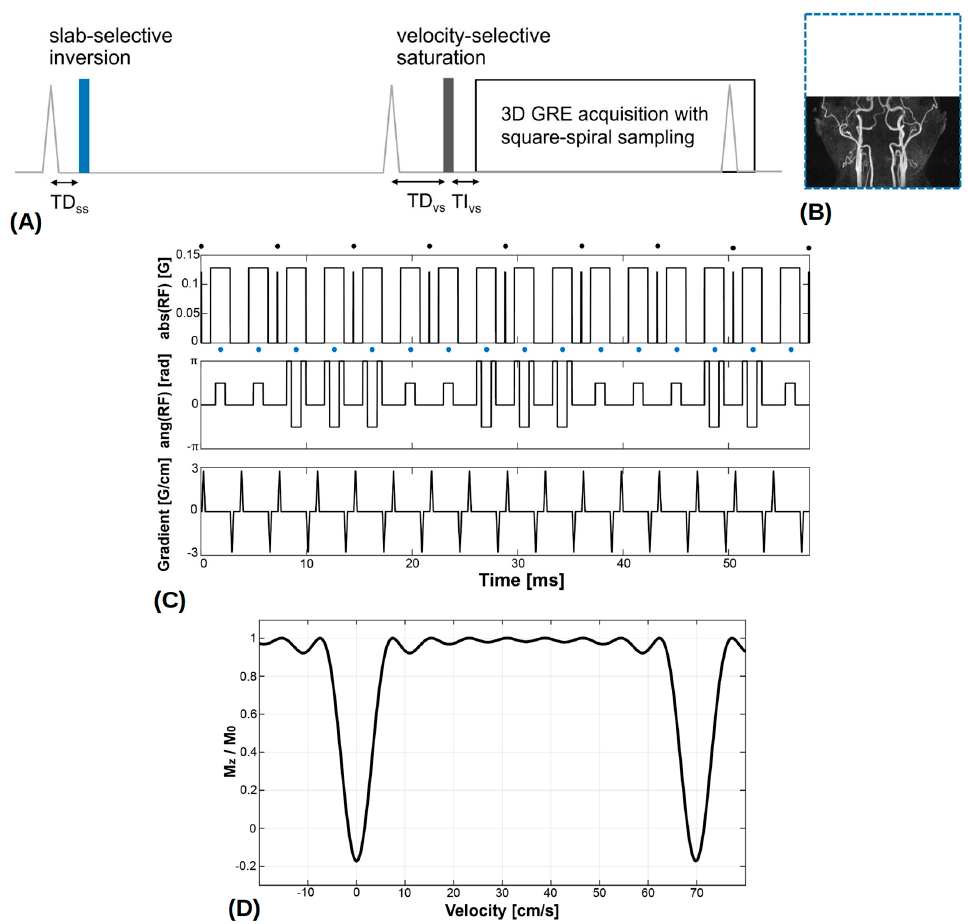
Figure 1. ( A ) Neck velocity-selective magnetic resonance angiography (VS-MRA) pulse sequence was triggered by ECG signals and played a slab-selective (SS) inversion preparation pulse at the onset of systolic flow. The thickness of the SS inversion preparation (blue dotted line) was larger than the imaging volume in the superior direction to encompass upstream venous flow ( B ). After the 2nd ECG triggering, a VS saturation preparation pulse was played near the time of peak systolic flow, followed by a fat saturation pulse and a segmented 3D GRE acquisition. ( C ) VS saturation pulse consisted of nine hard RF sub-pulses (denoted by black circles) interleaved with unipolar gradients for velocity encoding and 90° x − 180° y − 90° x composite pulses (denoted by blue circles) for refocusing. ( D ) Simulated Mz response over velocity, resulting from the VS preparation pulse where positive velocity represents the direction of arterial flow. (Abbreviation: TD = trigger delay; TI = inversion time).